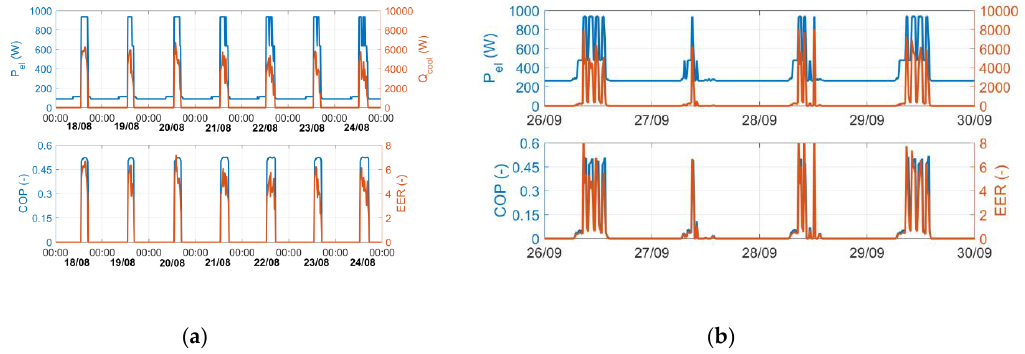
Figure 10. Performance results of proposed system prototype: the produced cooling output, the respective electrical consumption, and the corresponding COP and EER values ( a ) on hot summer days and ( b ) on cloudy days.